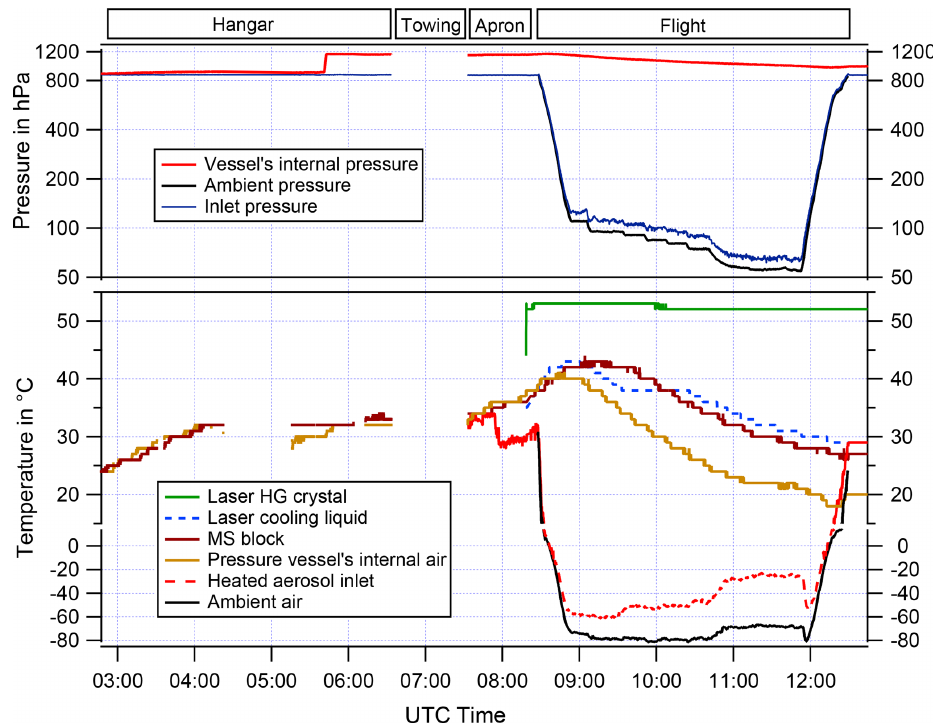
Figure 7. Temperature and pressure information during KTM 4 flight operations in Nepal on 2 August 2017. The graph includes the flight preparation time in the hangar and at the apron. The ambient pressure information is provided by the aircraft sensors via the UCSE; all other data are sourced from the sensors of the ERICA. The gaps in the lines indicate times during which the respective units were powered down.